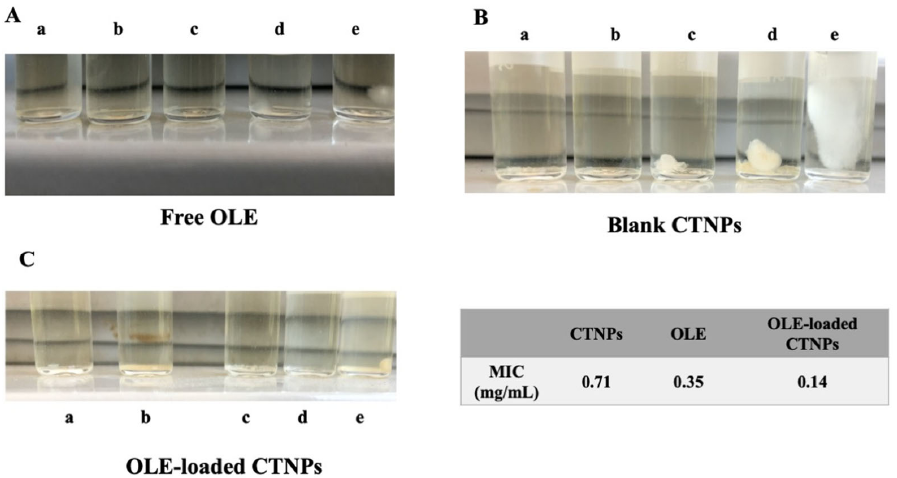
Figure 5. Minimal inhibition concentration (MIC) of OLE when free ( A ) and loaded in CTNPs ( B ); MIC of blank CTNPs was also evaluated at the same dilutions ( C ); a: 1.41 mg/mL; b: 0.71 mg/mL; c: 0.355 mg/mL; d: 0.142 mg/mL; e: 0.071 mg/mL.